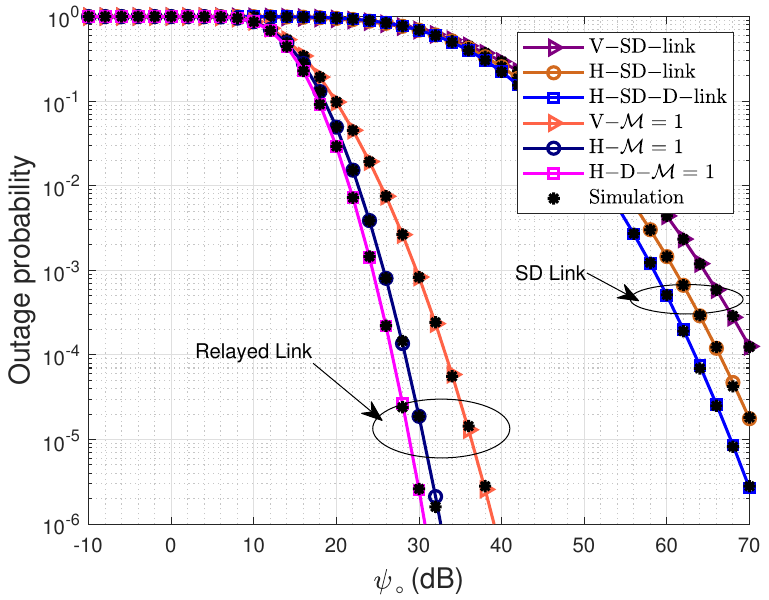
Figure 2. Outage probability versus average SNR ( ψ ◦ ) dB for SD and relayed link. Symbols V, H and SD represent the vertical, horizontal and direct non-relayed link from source to destination,